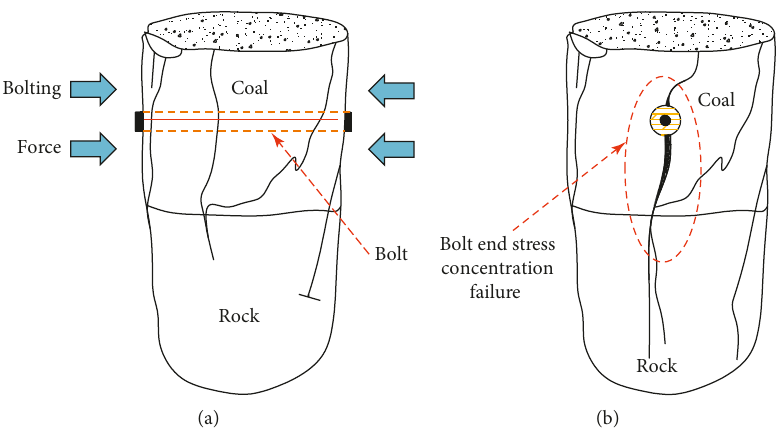
Figure 8: Rock bolt restriction specimen failure sketch map.